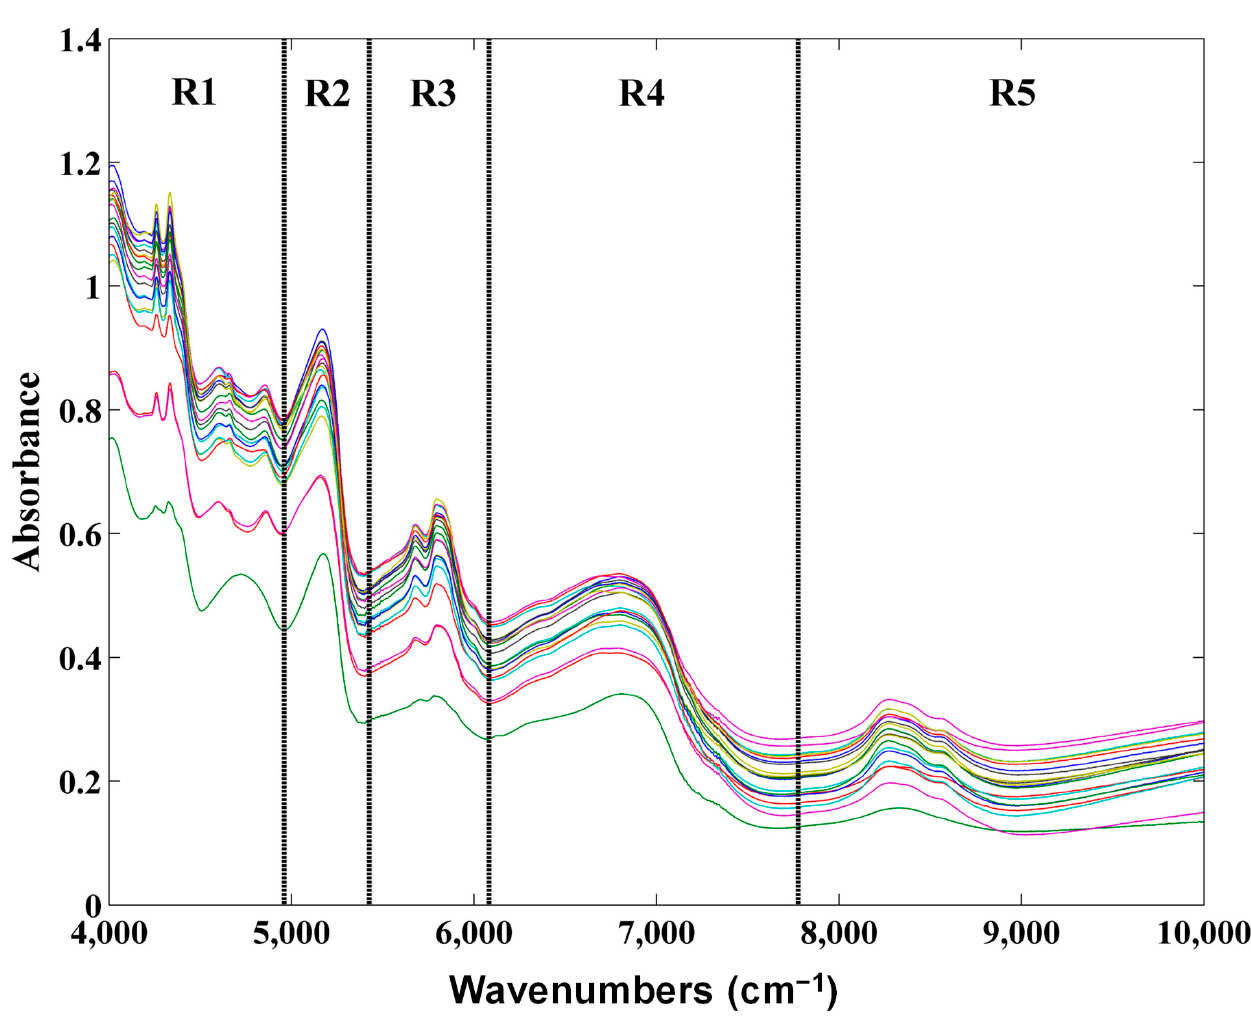
Figure 1. Raw NIR spectra of pine seeds.